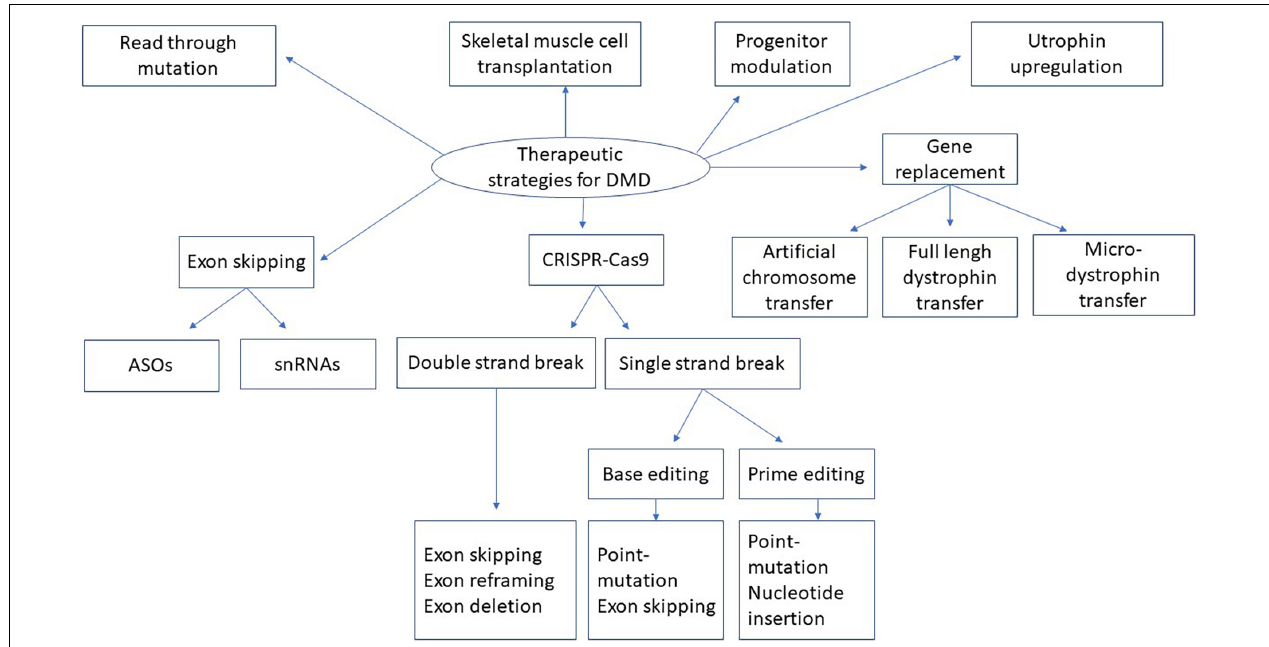
FIGURE 5 | Therapeutic strategies for DMD. This figure represents the summary of different strategies described in the present manuscript for dystrophin replacement in DMD. snRNA means small nuclear ribonucleic acid. ASOs means antisense oligonucleotides. CRISPR-Cas9 means Clustered Regularly Interspaced Short Palindromic Repeats, CRISPR-associated protein